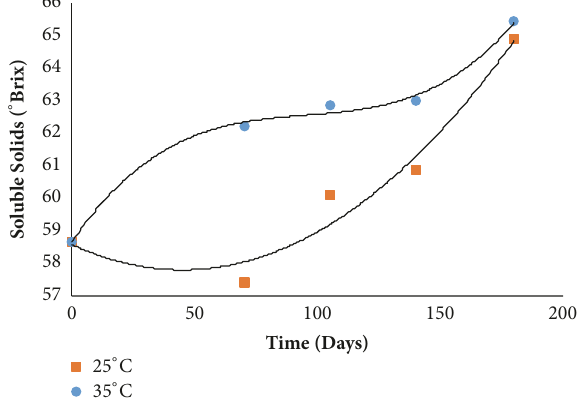
Figure 2: Total soluble solids during storage.